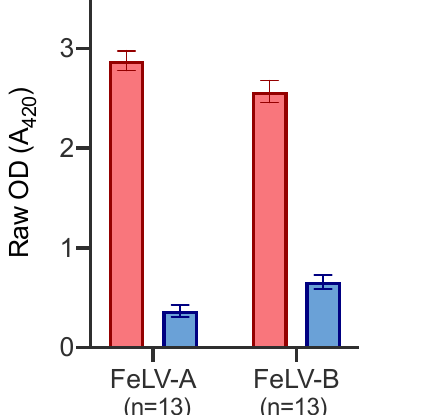
Figure 4. Intra- and inter-assay variation of FeLV-A SU ELISA. ( a ) Variation between samples tested in triplicate on the same plate. ( b ) Variation between samples tested on two different plates on two different days. Error bars represent standard deviation which was ≤ 0.13 in all cases.